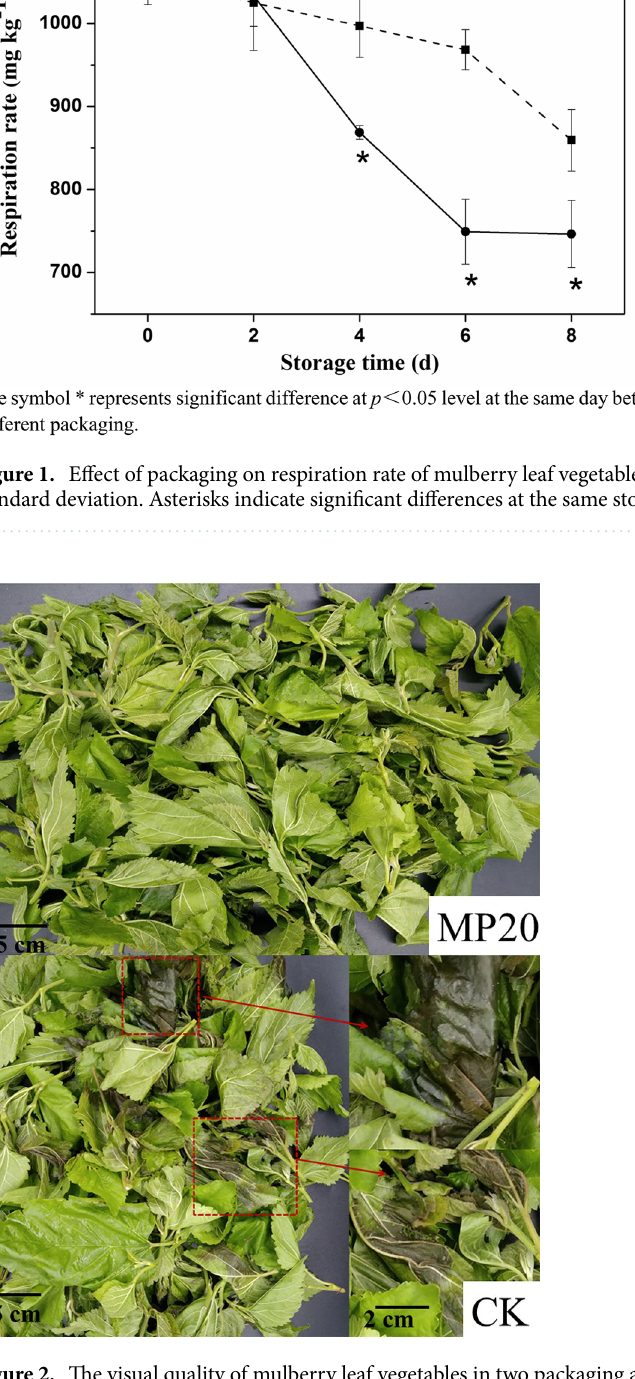
Figure 2. The visual quality of mulberry leaf vegetables in two packaging after storage 8 days at 4 °C. MP20 modified polyethylene packaging, CK normal polyethylene